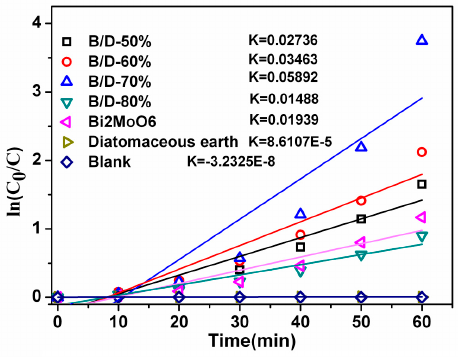
Figure 7. Kinetic process of RhB degradation for Bi 2 MoO 6 , diatomite, B/D-50%, B/D-60%, B/D-70%, and B/D-80%.